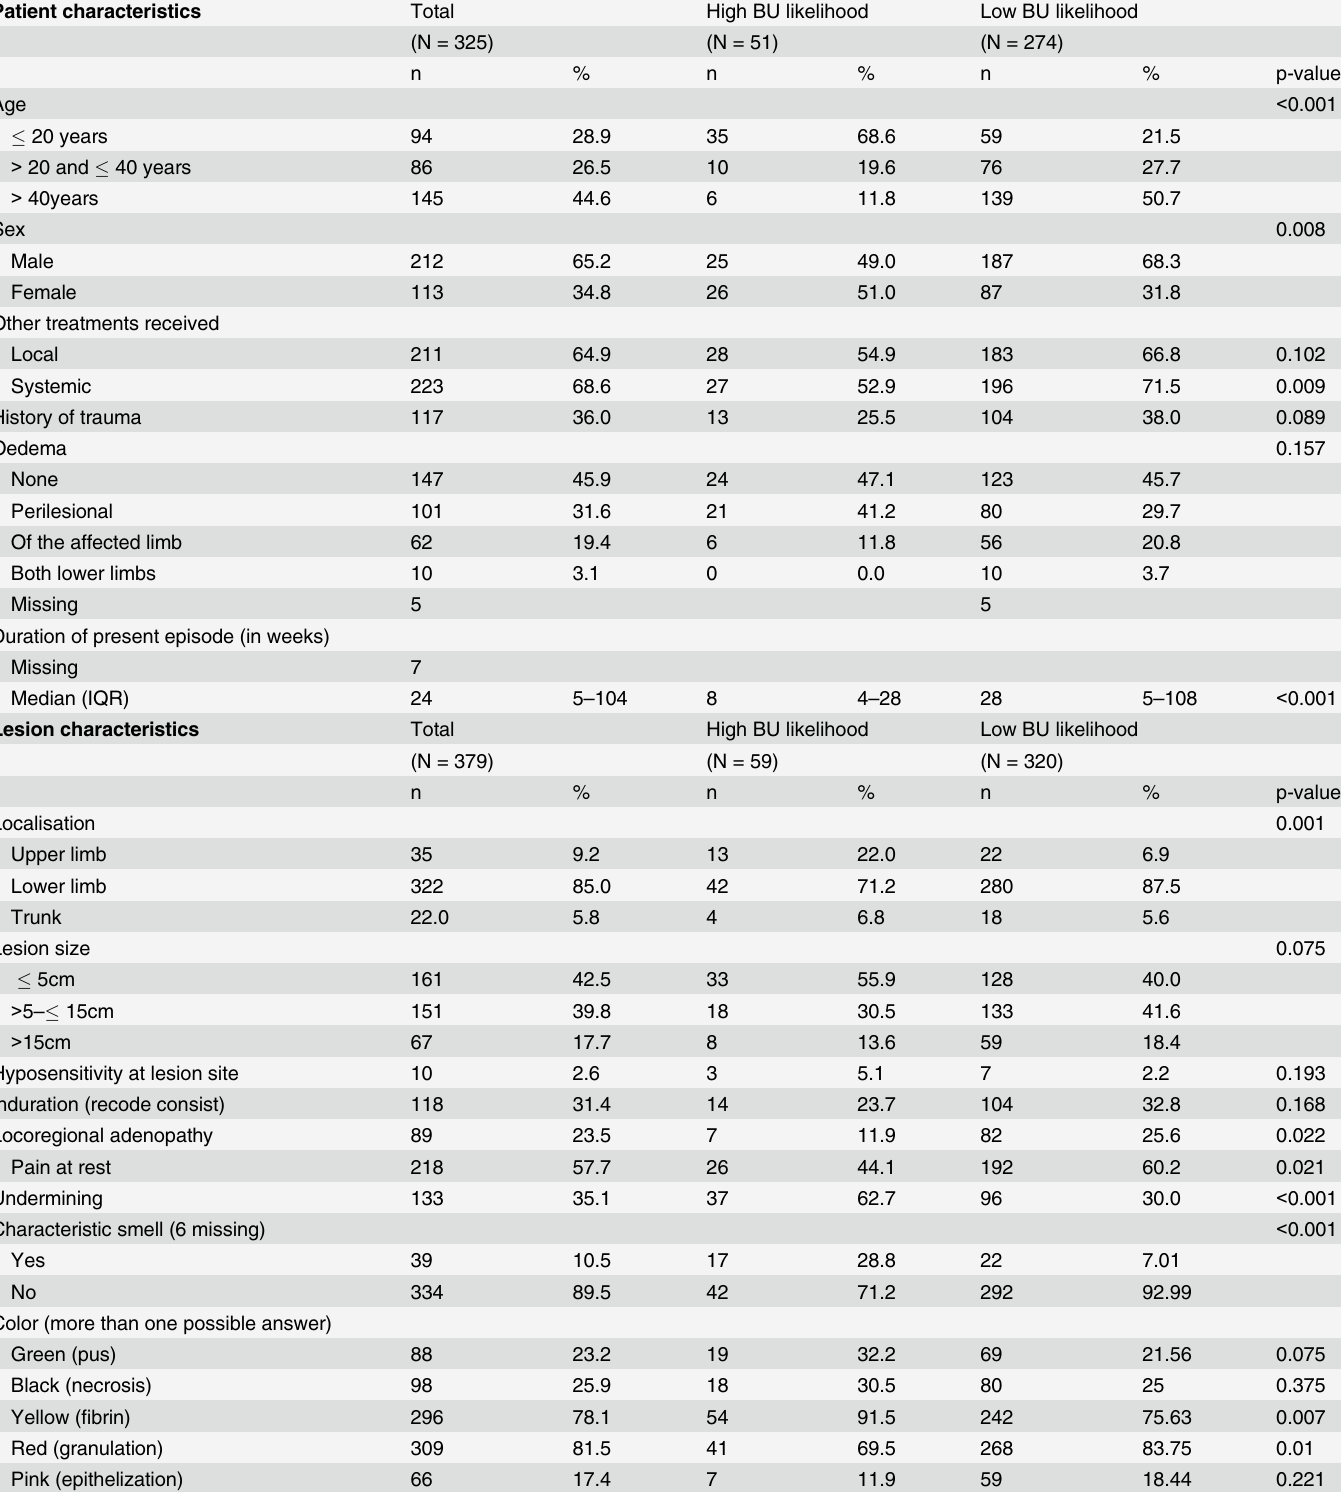
Table 1. Univariate analysis of variables associated with BU likelihood, Akonolinga,